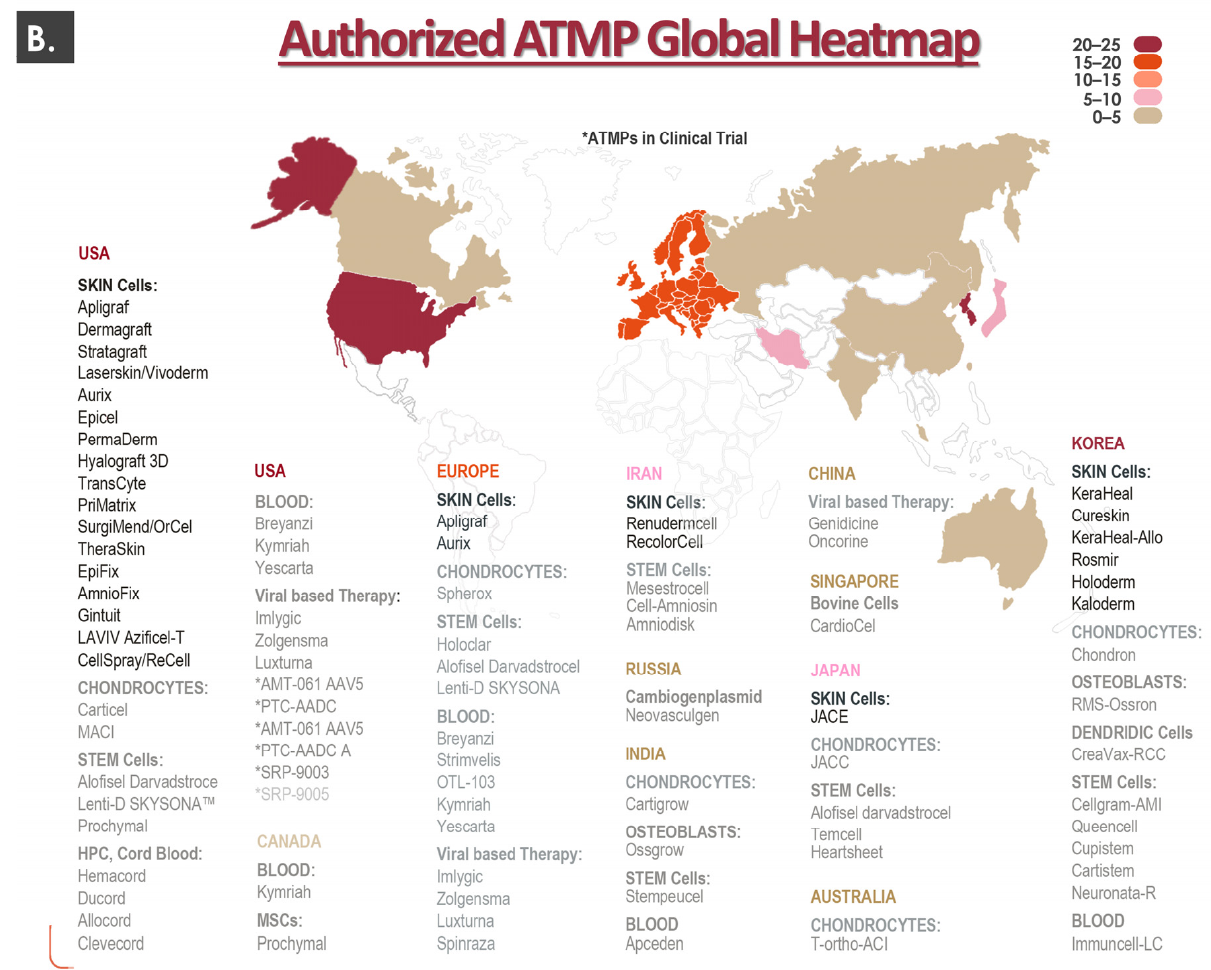
Figure 1. Overview of the current global cytotherapy ecosystem, with a focus on ATMPs for cutaneous application. ( A ) The upper portion of the figure presents a condensed summary of the available ATMPs, distributed into both product sub-categories and therapeutic indications. ( B ) The lower portion of the figure lists most of the authorized ATMPs, along with an illustration of the geographical distribution (i.e., heatmap) of product approvals. ATMP, advanced therapy medicinal product; CTMP, cell therapy medicinal product; GTMP, gene therapy medicinal product; MSC, mesenchymal stem cell; TEMP, tissue-engineered medicinal